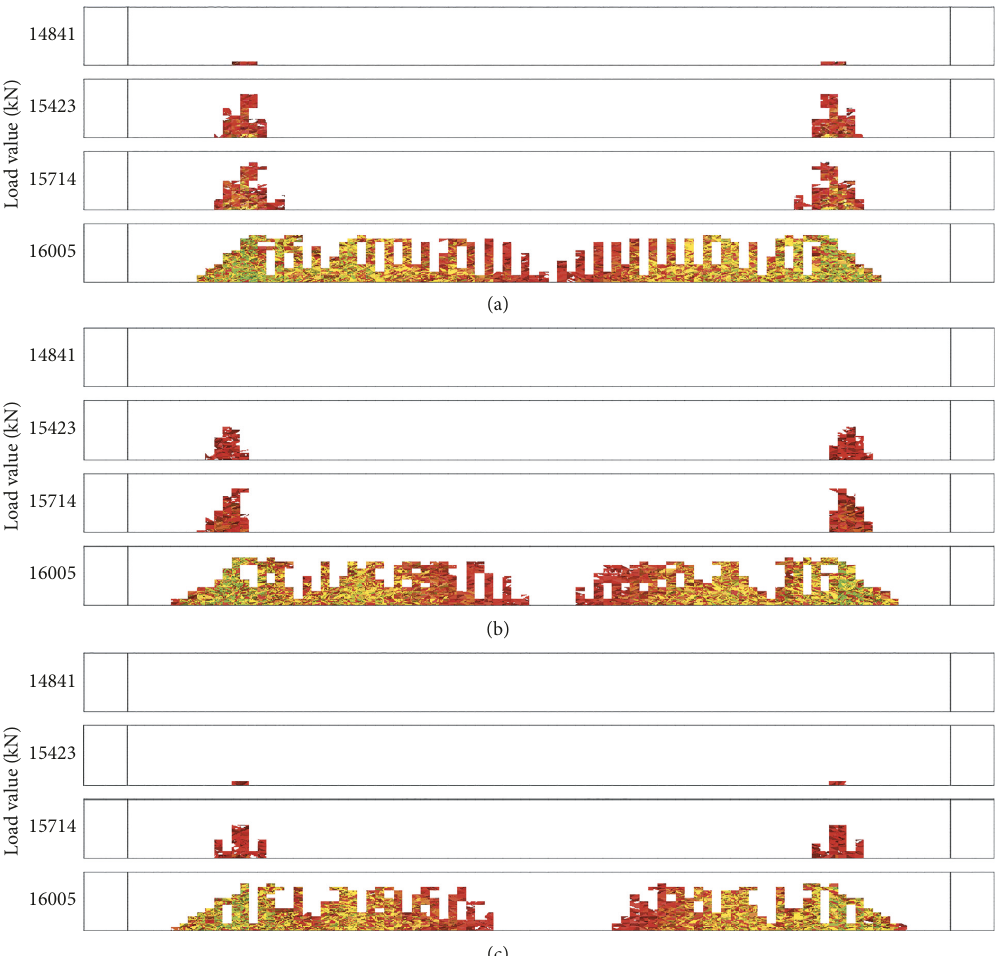
Figure 15: Crack distribution of webs. (a) Crack distribution of S-Webs. (b) Crack distribution of SS-Webs. (c) Crack distribution of M-